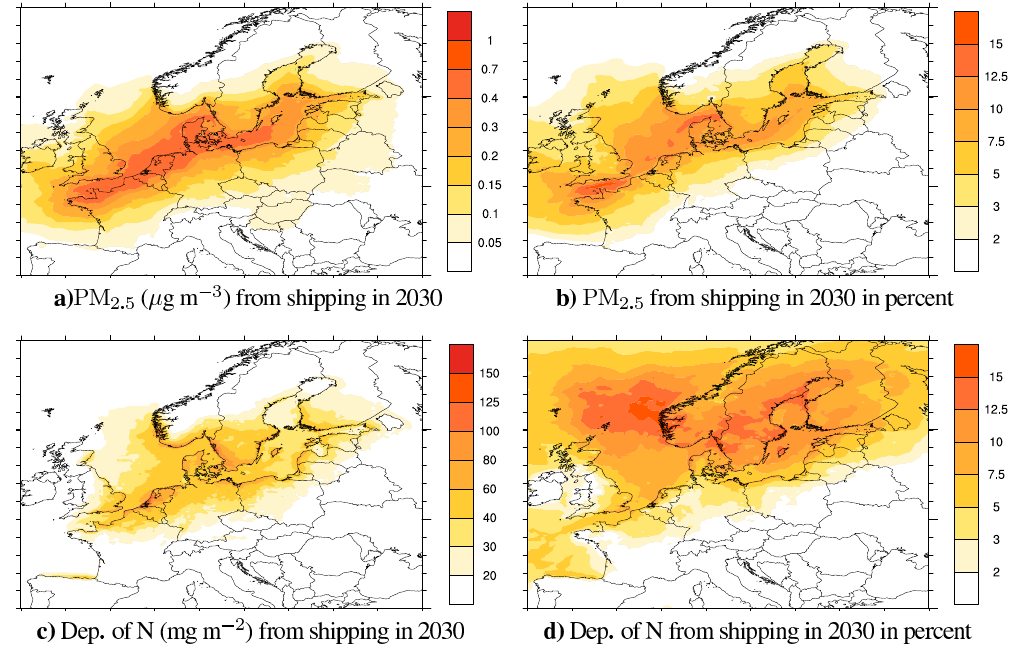
Figure 8. Contributions from ship emissions in the Baltic Sea and the North Sea in year 2030 to PM 2 . 5 concentrations (a) and in percent (b) . Contributions to the total deposition of nitrogen in mgm − 2 (c) and in percent (d) .